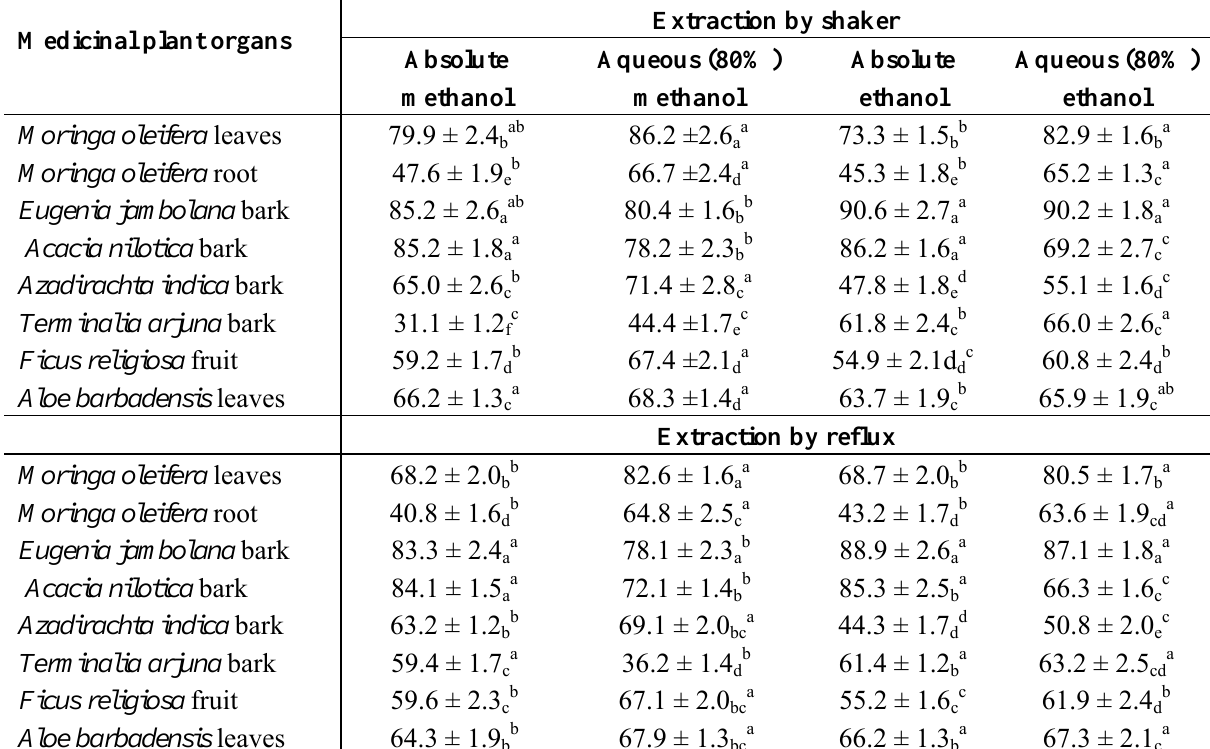
Table 6. Effects of extracting solvent/technique on the percent inhibition of linoleic acid peroxidation of different medicinal plant materials. Medicinal plant